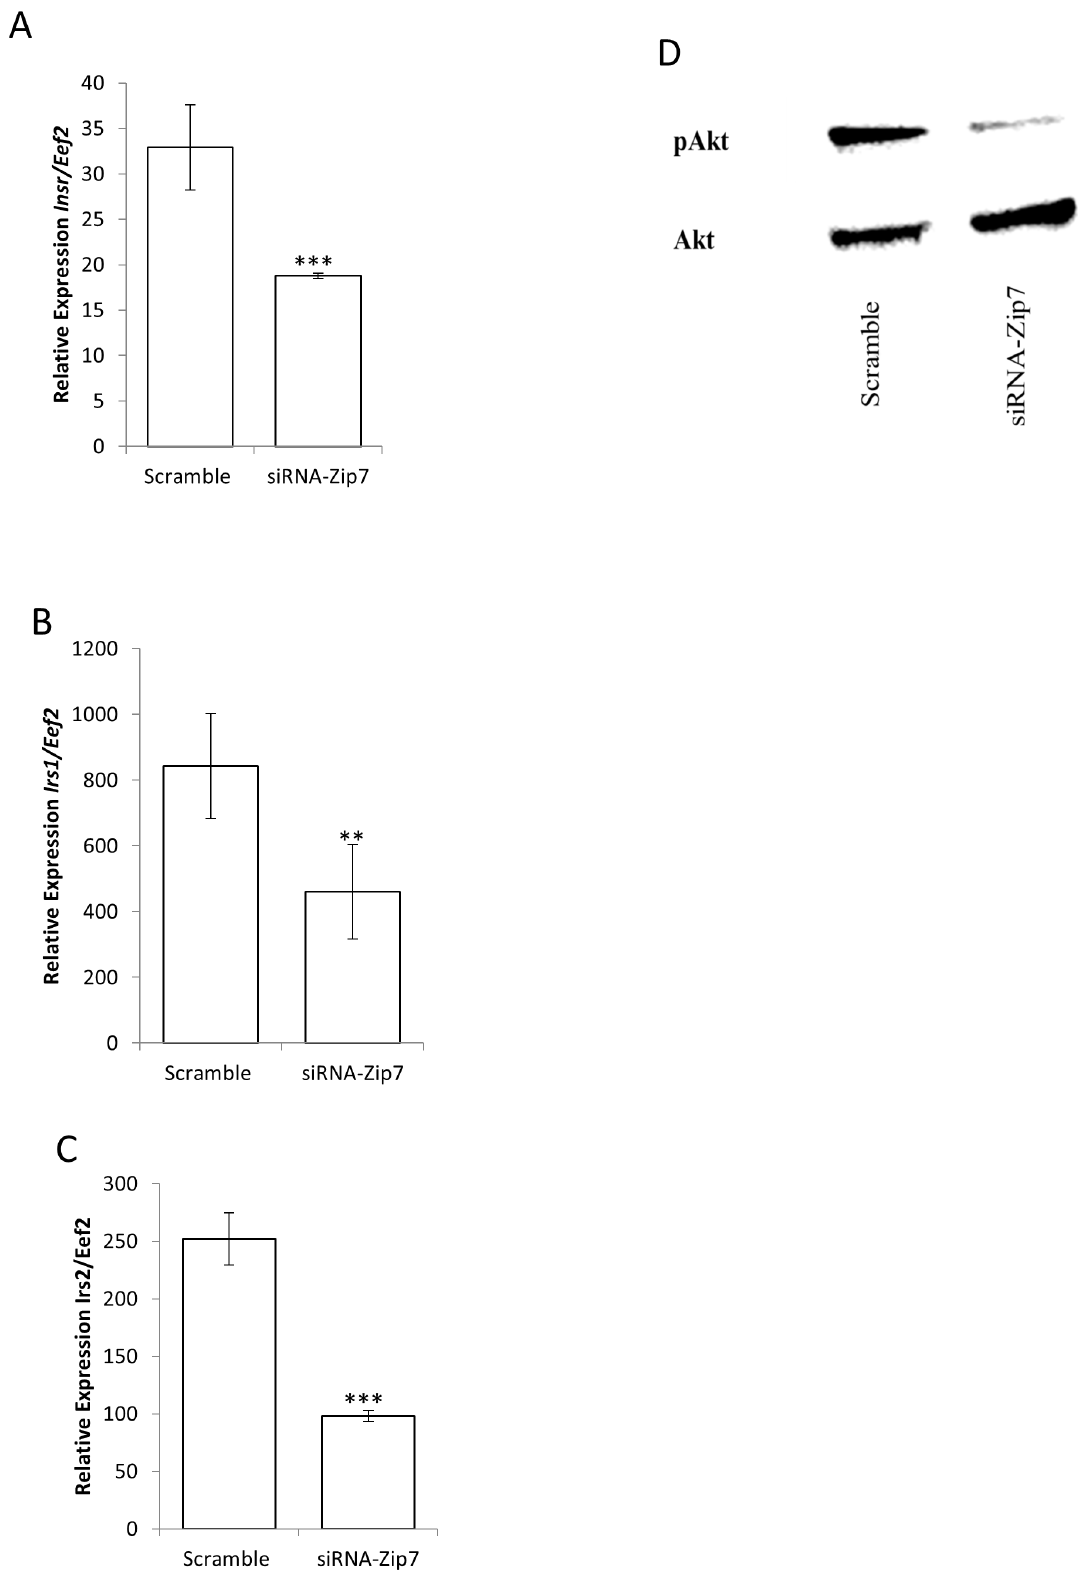
Figure 7. Reduced Zip7 expression reduces the mRNA expression of the insulin receptor (Insr), insulin receptor substrate 1 (Irs1), insulin receptor substrate 2 (Irs2) and the phosphorylation of AKT. A–C). Relative expression of Insr , Isr1 and Isr2 mRNA to Eef2 in the scramble control and the siRNA- Zip7 C2C12 skeletal muscle cells. D. Western blot for immunoreactive pAkt and Akt in protein lysates isolated from